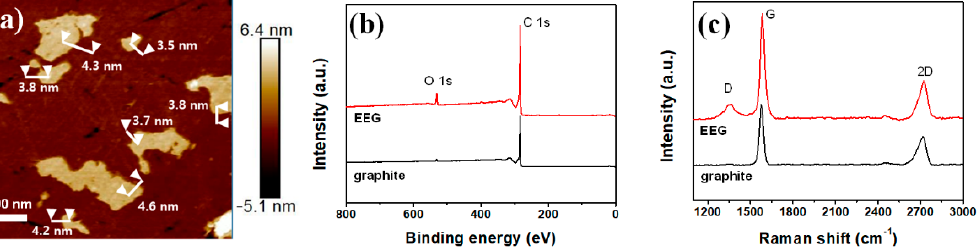
Figure 3. ( a ) AFM image of EEG on silicon substrate. ( b ) XPS and ( c ) Raman spectra of EEG and graphite. and